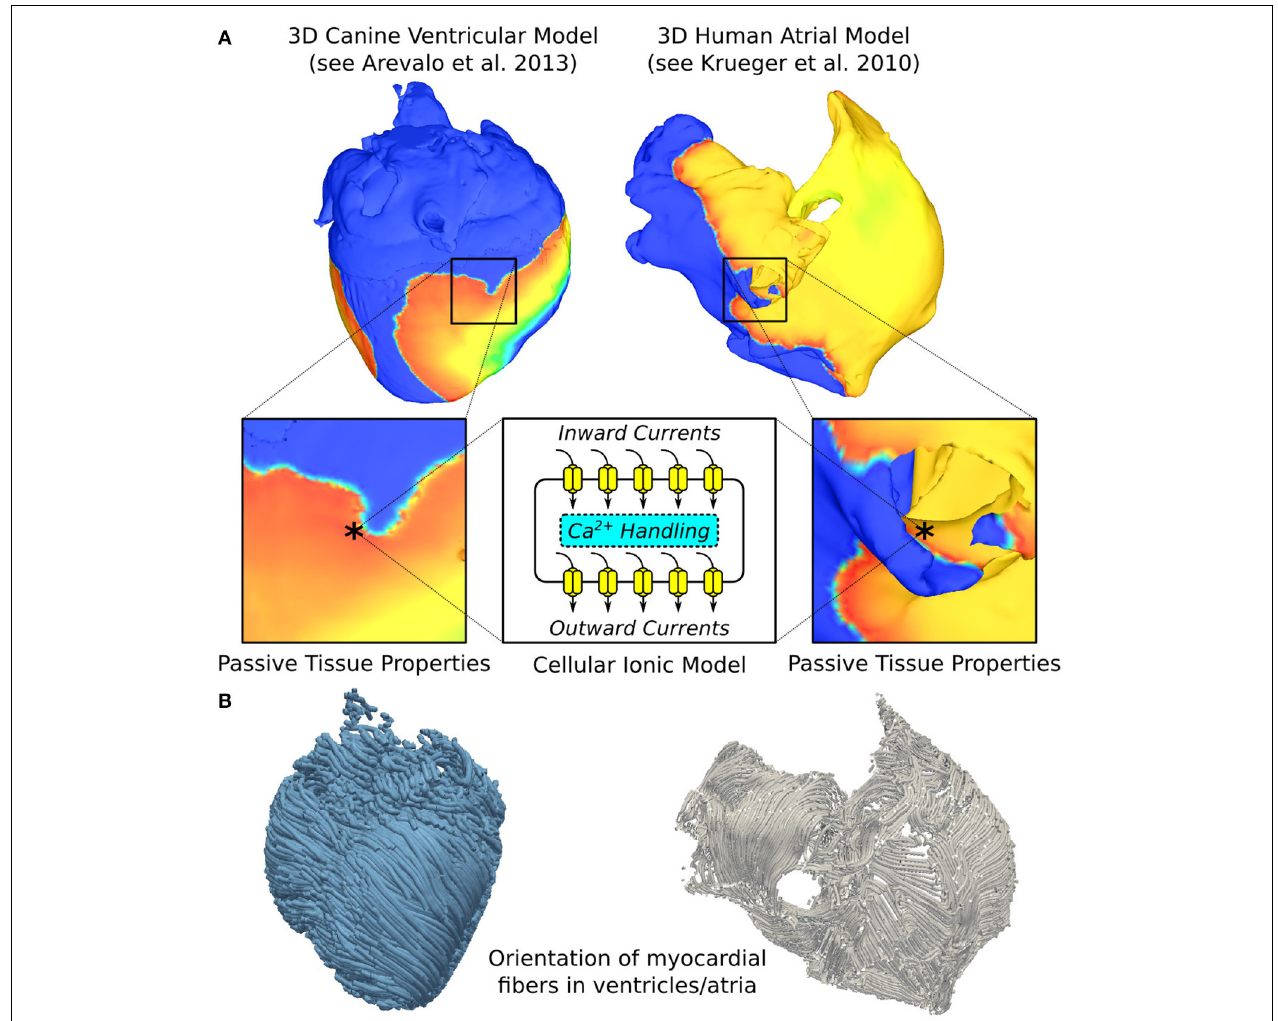
FIGURE 1 | Overall approach to image-based modeling of cardiac electrophysiology. (A) The multiscale aspect of cardiac electrophysiological models. Passive electrical coupling of cardiac cells mediates the tissue-scale propagation of bioelectric impulses that originate at the membrane level (action potentials). ∗ indicates representative points in ventricular and atrial